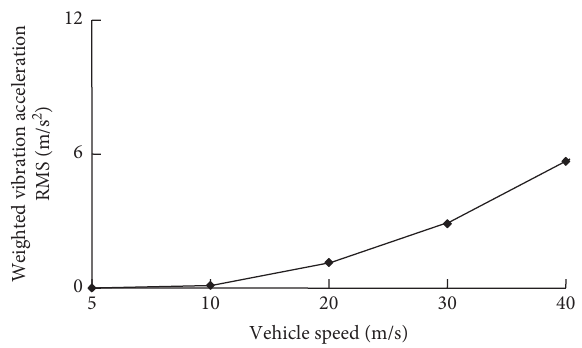
Figure 21: The variation curve of weighted vibration acceleration root mean square (RMS) value of the vehicle body.